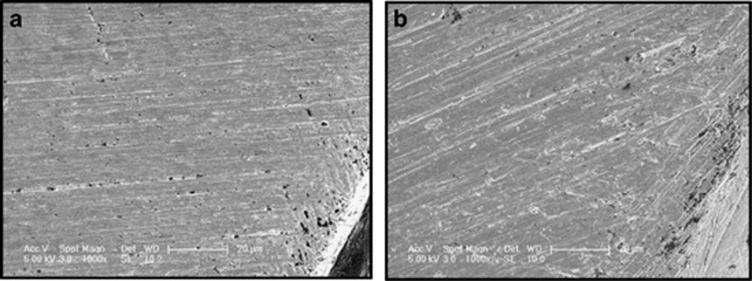
Post-immersion SEM images of the contacting surfaces of an implant and a Ti alloy abutment. (a) Implant; (b) Ti abutment. Magnification x1 000. Pitting corrosion at the outer border of a titanium implant and a Ti alloy abutment from the TM group after immersion for 1 week at 37° in 1% lactic acid solution. SEM, scanning electron microscopy; Ti, titanium; TM, connected platform-matched titanium abutment (6 mm).